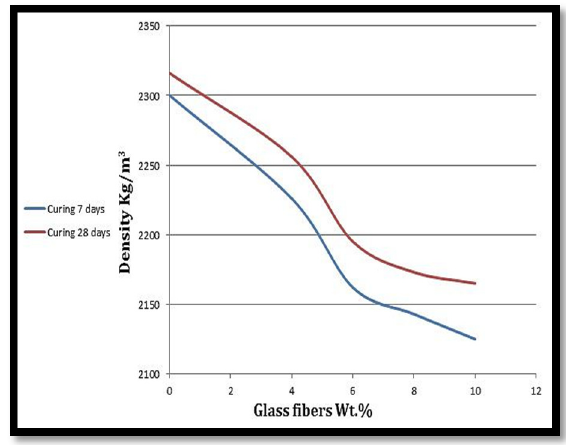
Fig. 7. Comparison between glass fibers reinforced mortar without SBR and glass fibers reinforced mortar with SBR after curing for 28